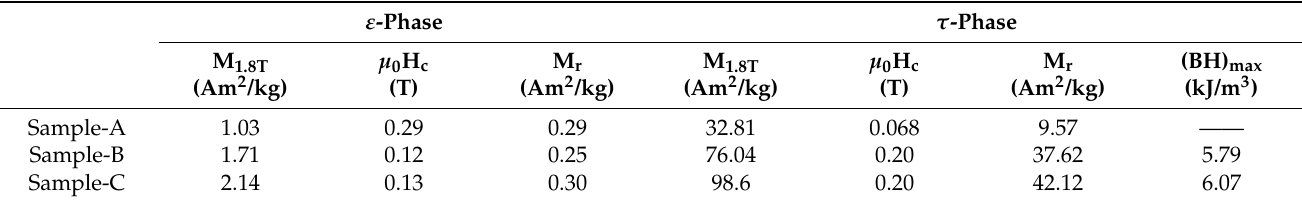
Figure 4. Magnetic hysteresis loops for all samples in the ( a ) quenched [ ε ] and ( b ) annealed [ τ ] states. ( c , d ) are Thamm–Hesse curves estimated from ( a , b ). Table 2. Summary of the magnetic